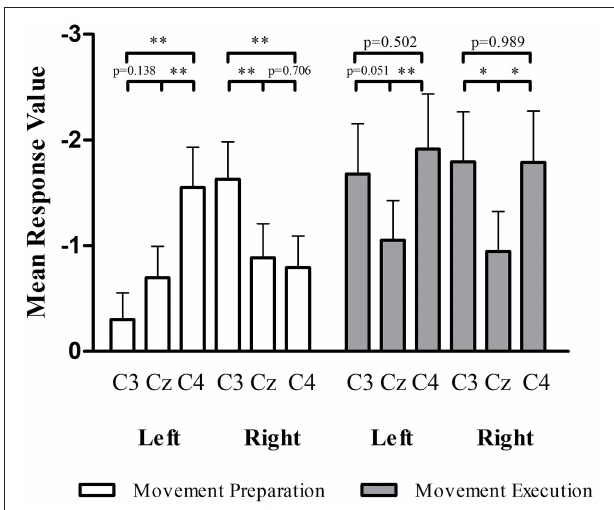
FIGURE 6 | mu ERD at C3, Cz, and C4 in movement preparation and movement execution stage of CIRM. In the movement preparation stage, the contralateral sensory motor cortex (C4 for left wrist movement, C3 for right wrist movement) showed larger mu ERD than other locations ( p < 0.05). In the movement execution stage, Cz showed the lowest amplitude of mu ERD and no significant differences found between C3 and C4. * p < 0.05, ** p < 0.01